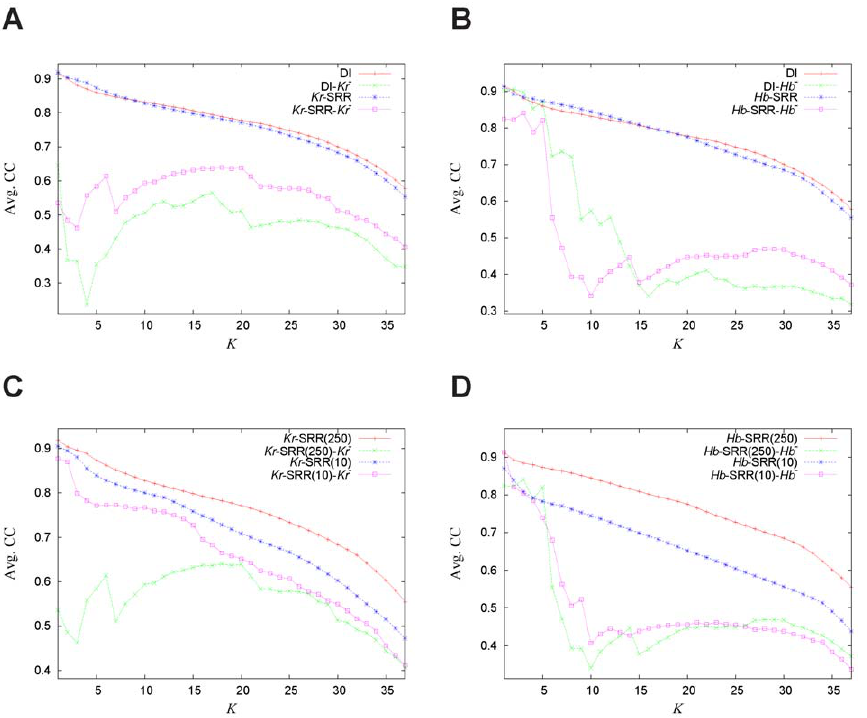
Figure 4. Evaluation of short range repression (SRR) model. (A,B) Two of the four repressors ( Kr and Hb ) are evaluated separately, by comparing predictions from a model where one repressor is modeled through DirectInt (‘‘DI’’) to predictions from a model where that repressor acts through SRR (‘‘ Kr- SRR’’and ‘‘ Hb- SRR’’, in panels A and B respectively). For each model, the average correlation coefficient (CC) of the K best predictions (CRMs) of that model is shown, as a function of K . Also shown for each model is the average CC (over the same K CRMs) when the repressor is ‘‘knocked down’’ (e.g., ‘‘DI- Kr 2 ’’, ‘‘ Kr- SRR- Kr 2 ’’ in panel A). (C,D) The SRR model for (C) Kr and (D) Hb (with range of repression d R =250 bp) is compared to the corresponding model at d R =10 bp, where the repressor can only affect overlapping or adjacent sites. Semantics of the plots are as in (A–B).